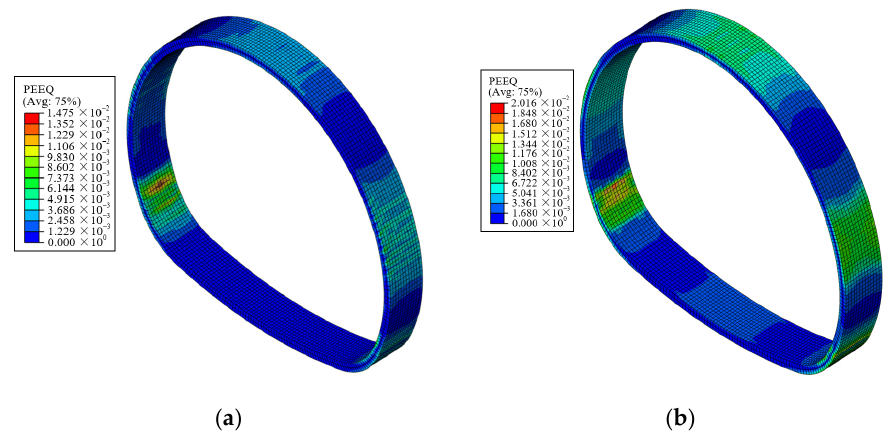
Figure 21. Cloud diagrams of concrete plastic damage. ( a ) SRS arch and ( b ) grid arch.